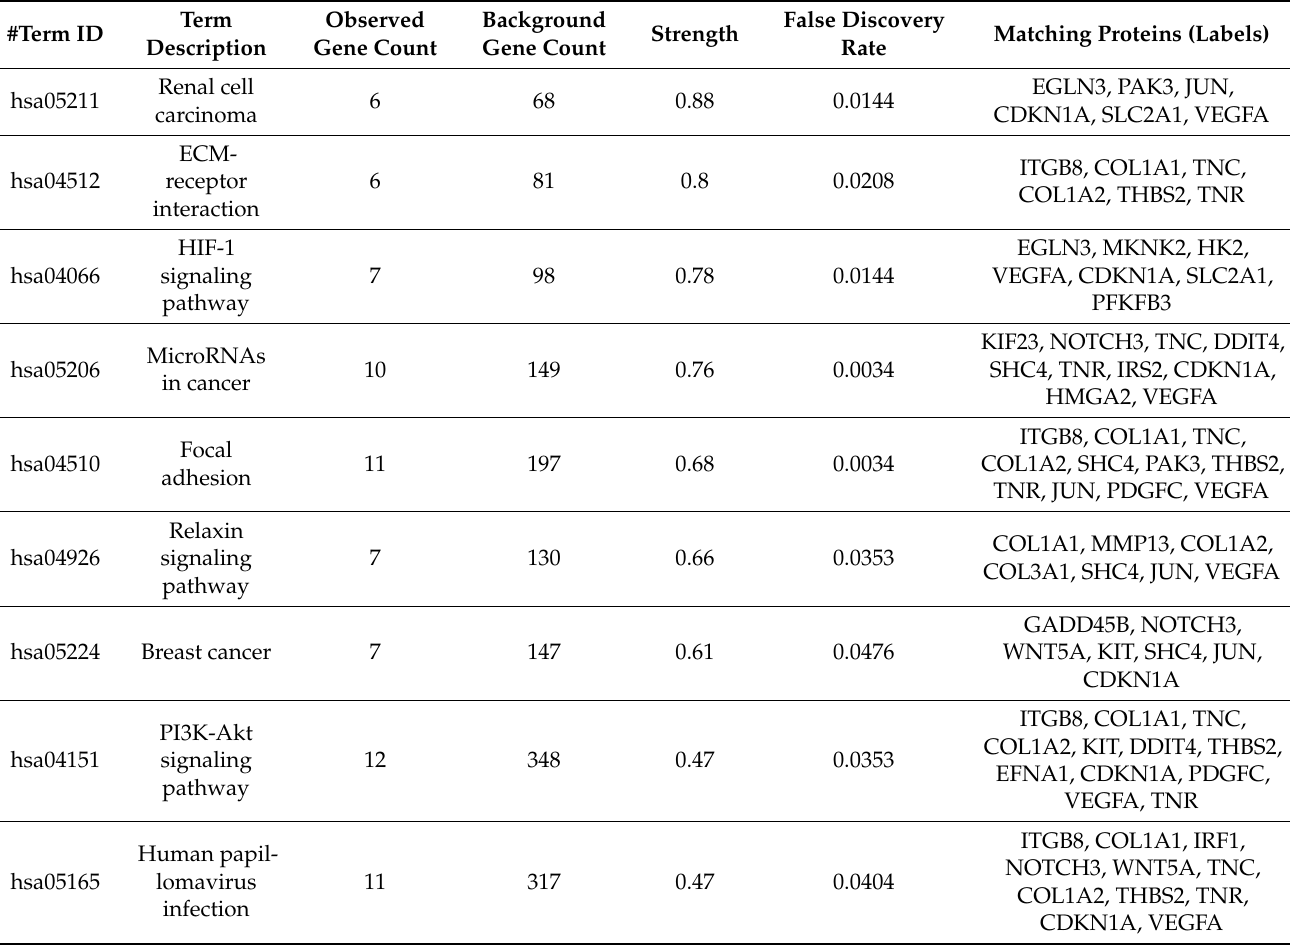
Table 1. KEGG pathway enrichment